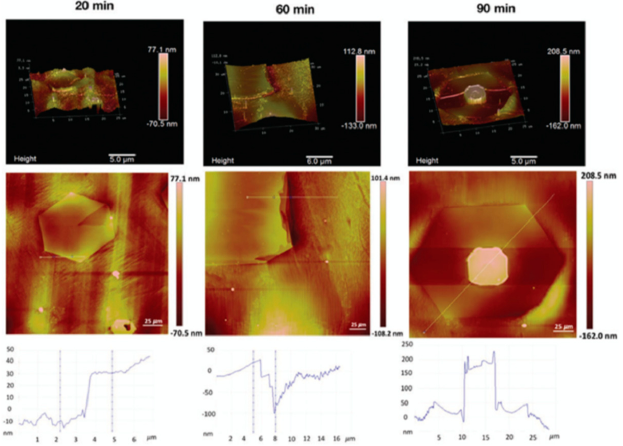
Figure 31. AFM images showing surface topography with a quantitative height line scan across hexagonal growth defects on graphene films grown on Cu / Mo substrate using APCVD (reprinted with permission from [49]).